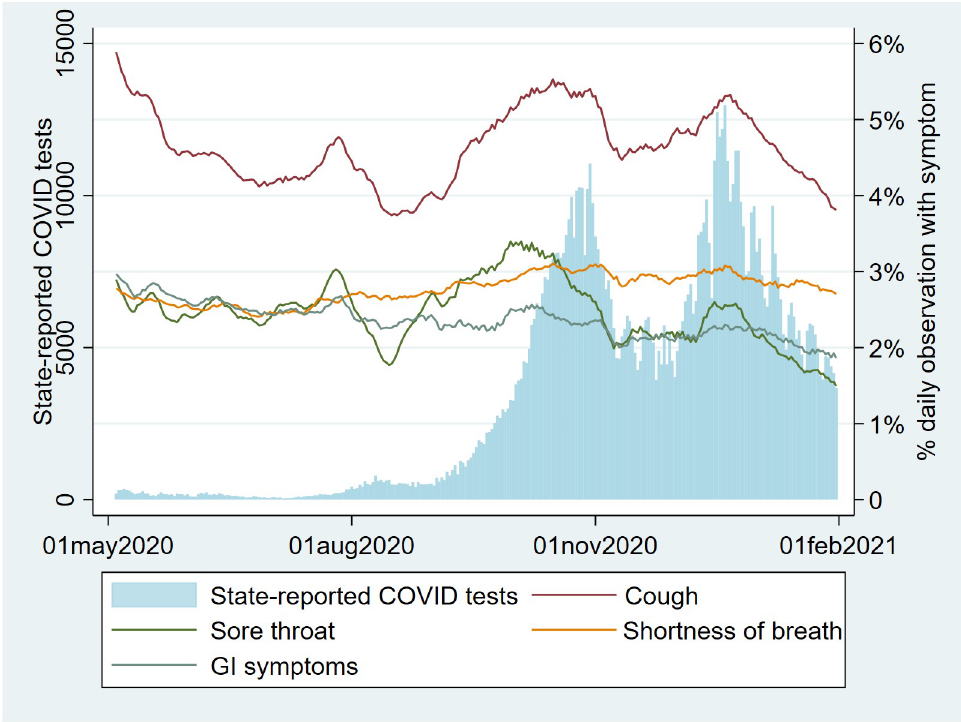
Fig 8. Symptoms vs. time alongside number of nationally reported positive SARS-CoV-2 tests (percentage of users reporting cough, sore throat, GI (gastrointestinal) symptoms, and shortness of breath).